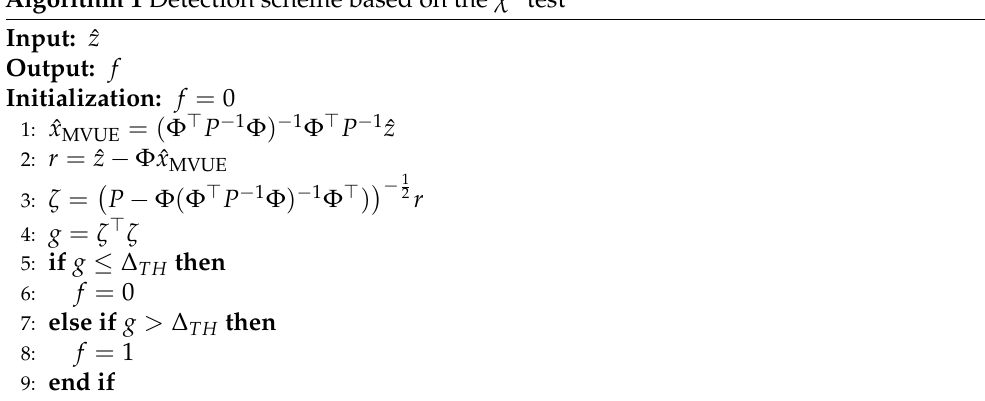
Algorithm 1 Detection scheme based on the χ 2